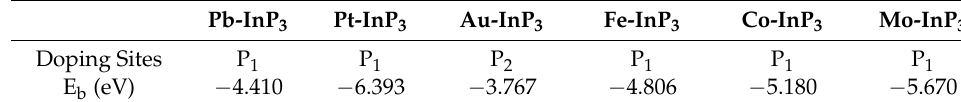
Table 1. Optimum doping sites and binding energies of TM-doped InP 3 .